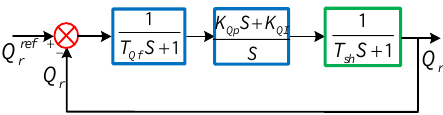
Figure 14. The unity-feedback reactive power control loop of the shunt converter.